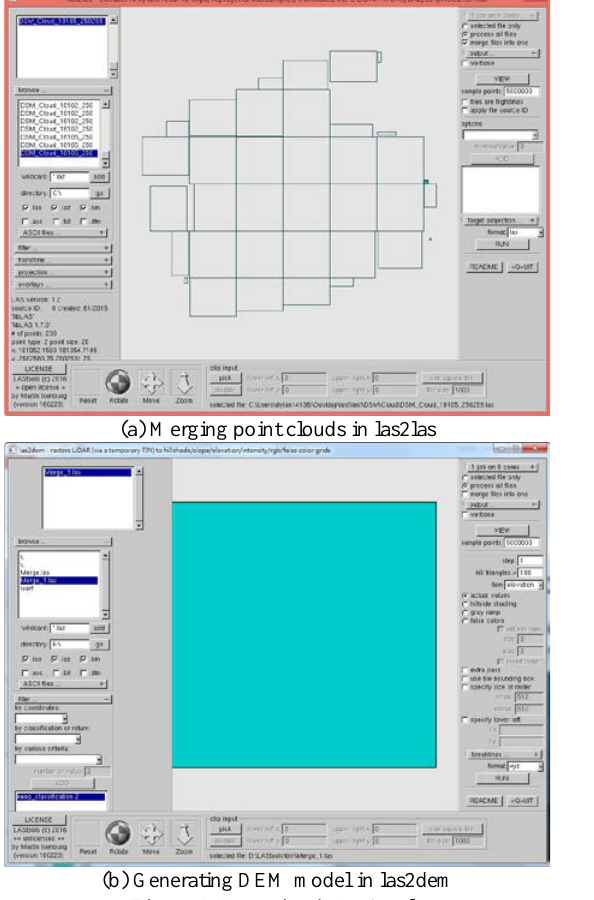
Figure 4. Operation in LAStools